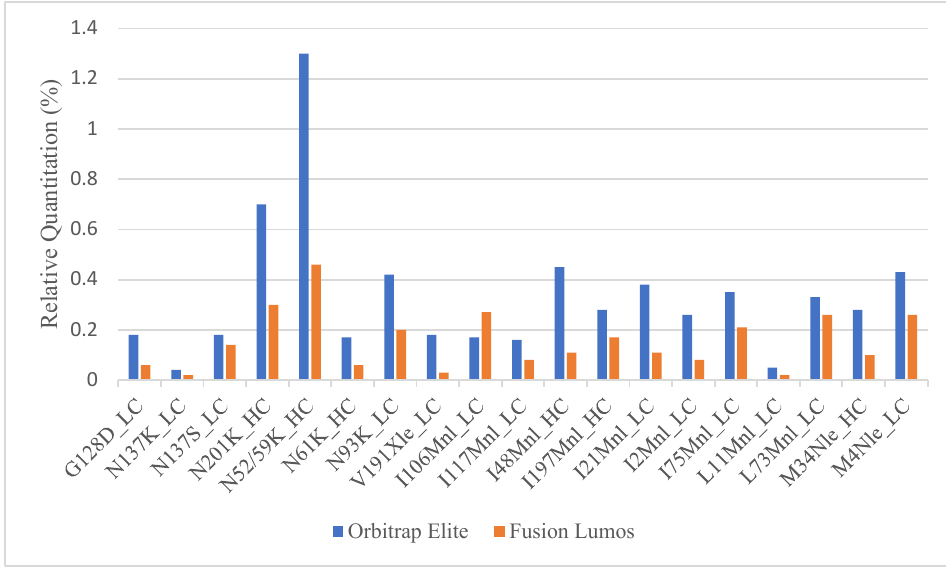
Figure 2. Comparison of the relative quantitation of true positive sequence variants obtained in Orbitrap Elite vs. Fusion Lumos.